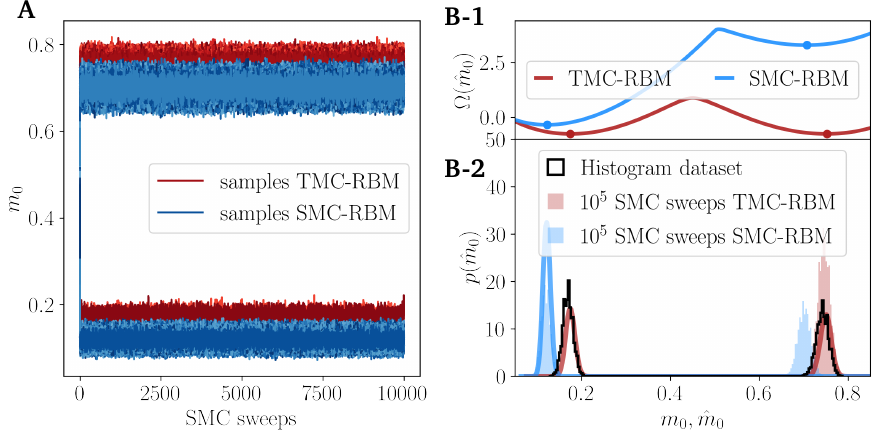
Figure 4: We compare RBMs trained with two different sampling procedures. We analyze models trained for 481 parameter updates and a learning rate of 10 − 2 for the TMC-RBM and 10 − 4 for the SMC-RBM. The SMC-RBM is trained with PCD and 10 MC sweeps of Glauber dynamics (the standard procedure, SMC), and the TMC- RBM is trained with PCD and 10 TMC1D sweeps fixing the projection m . Once both 0 machines are trained, we can sample their configuration space with SMC moves in ( t ) for 1000 independent A or TMC moves in B . In A we show the evolution of m 0 simulations initialized at random (in blue we show the samplings of SMC-RBM, in red of the TMC-RBM). Fig. A shows that ergodicity is completely broken: Markov chains remain trapped in the state closest to their random initialization, and not a single jump from one state to the other is ever observed. This means that thermalization is not even close, and it is impossible to properly estimate the relative height of the two peaks from SMC simulations. In B , we instead take both machines under the microscope using the TMC algorithm to properly explore the equilibrium measure. The TMC results are shown in thick solid lines. In B-1 we show the TMC effective potential Ω ( ˆ m ) , which has 2 relative minima for both models. We mark the position of these minima with large dots. We can easily see that they coincide with the mean projection of the two states we sampled with SMC in A . However, in the case of the SMC-RBM, the left minima is much lower, which translates into a much higher TMC probability once p ( ˆ m ) is computed in B-2 . It is clear that none of the reconstructed equilibrium probabilities match the histograms obtained with the non-ergodic SMC